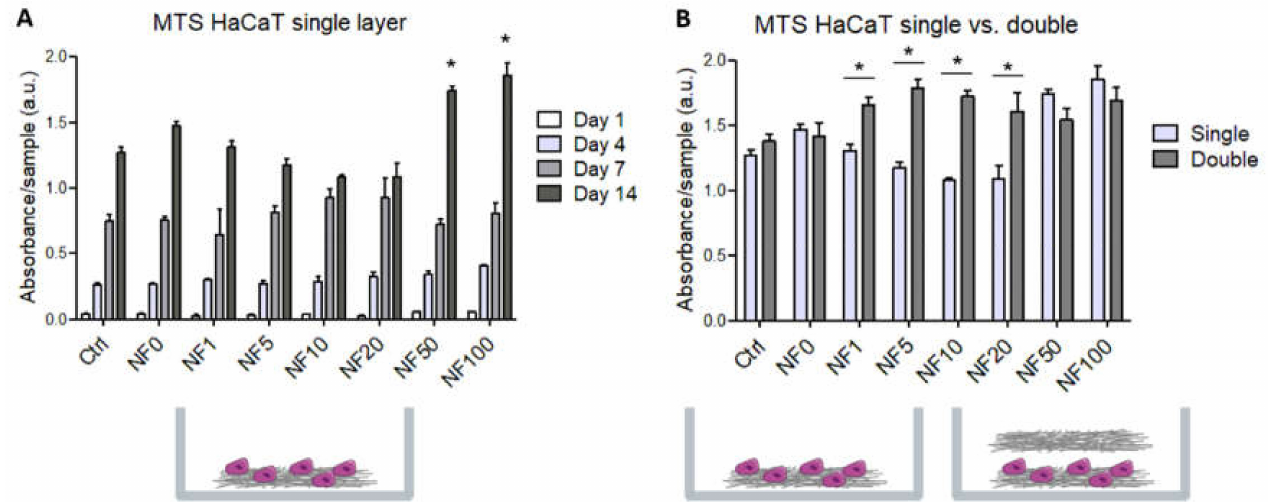
Figure 6. Metabolic activity/viability of the HaCaT cells that grew on the NF membranes with fibrin assemblies prepared using differing platelet lysate (PL) concentrations, i.e., 0, 1, 5, 10, 20, 50 and 100% PL (NF0, NF1, NF5, NF10, NF20, NF50, NF100, respectively). Pure NF membranes were used as the control sample (Ctrl). ( A ) HaCaT cells were grown on a single layer of NF for 1, 4, 7 and 14 days. The asterisks above the columns indicate significant differences compared to the control membrane ( p < 0.05). ( B ) Comparison of the cells that grew on the NF membranes for 14 days (single) and the cells that grew on the NF membranes in a medium to which additional NF membranes with corresponding PL concentrations were added on day 7 following seeding (double). The asterisks above the columns indicate significant differences between the single and double layers ( p <